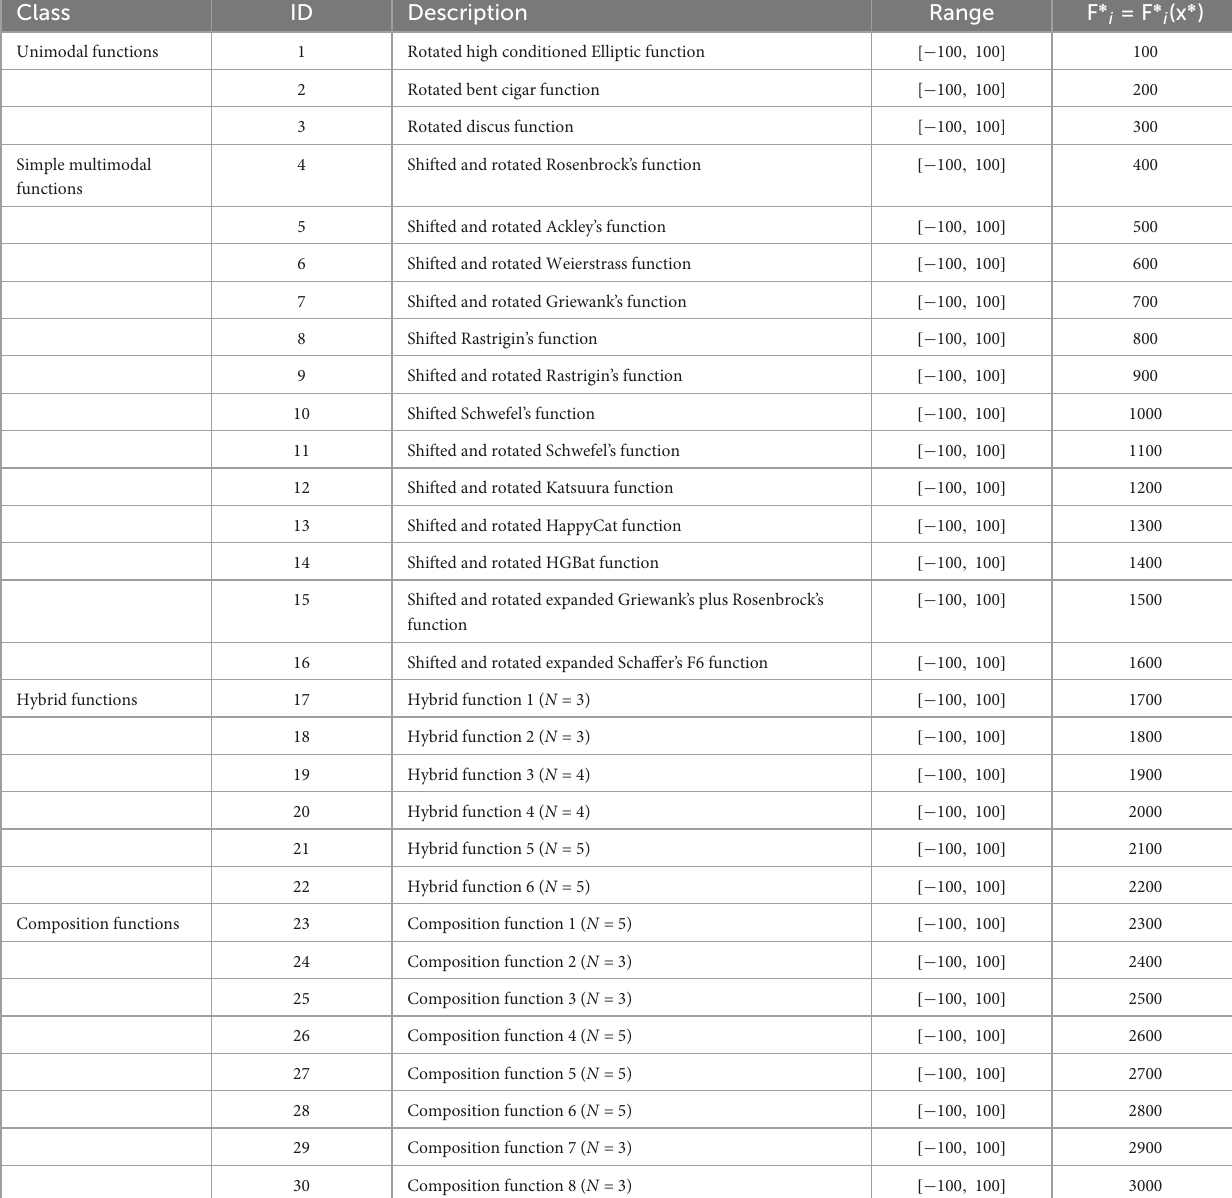
TABLE 1 The brief description of IEEE